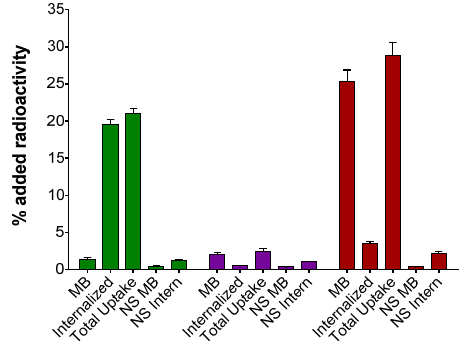
Figure 3. Figure 3. Uptake/internalization of  [ 67 Ga]Ga-DOTA-TOC,  [ 67 Ga]Ga-DOTA-LM3 and  [ 67 Ga]Ga- DATA 5m -LM4 after 1 h incubation in HEK293-SST 2 R cells at 37 °C; results represent the average values